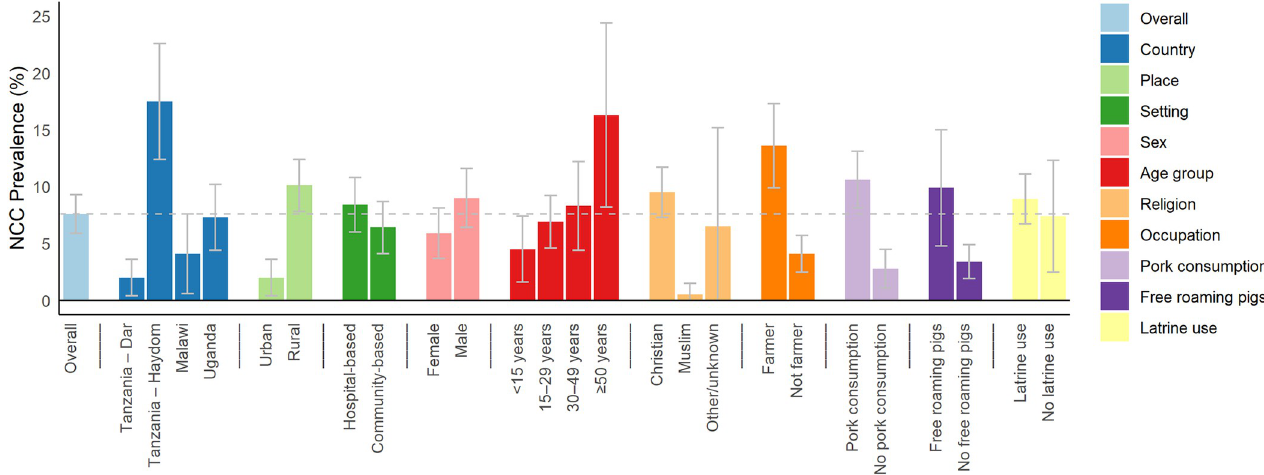
Fig 2. Neurocysticercosis prevalence disaggregated by study-specific and socio-demographic factors.